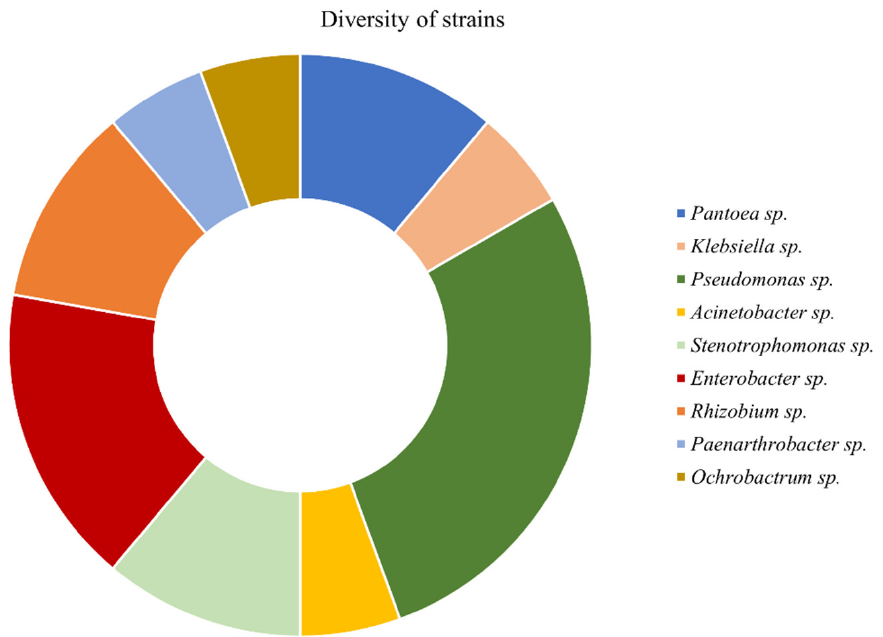
Figure 1. Bacterial genera of strains isolated from two natural plant species growing in Sal Island (Cape Verde) soils. For more information, related to bacterial strains see Supplementary Table S1.